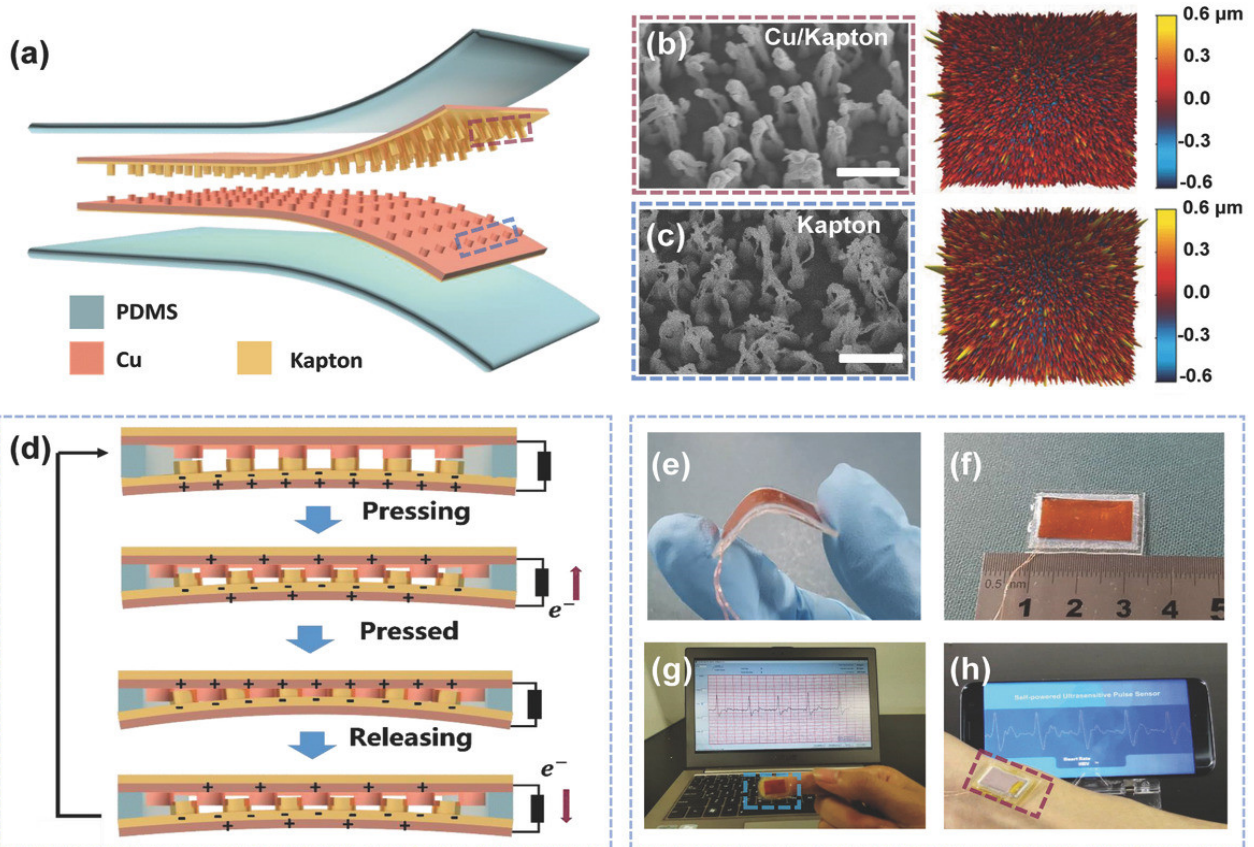
Figure 19. Components and operating mechanism of the SUPS developed by Ouyang et al. [111]. ( a ) Schematic view of the structure of the triboelectric nanogenerator of the SUPS. ( b , c ) SEM and atomic force microscopy (AFM) images of the nanostructured Cu and Kapton film, respectively. ( d ) Sche- matic view of the operating principle of the triboelectric nanogenerator. ( e ) Illustration of the good flexibility of the SUPS. ( f ) Image of the size of the SUPS structure (2 cm × 1 cm). ( g , h ) Experimental results of the signal outputs of SUPS pressed on the finger and radial artery region, respectively. Reprinted with permission from [111]. Copyright 2017, WILEY-VCH Verlag GMbH & Co. KGaA,